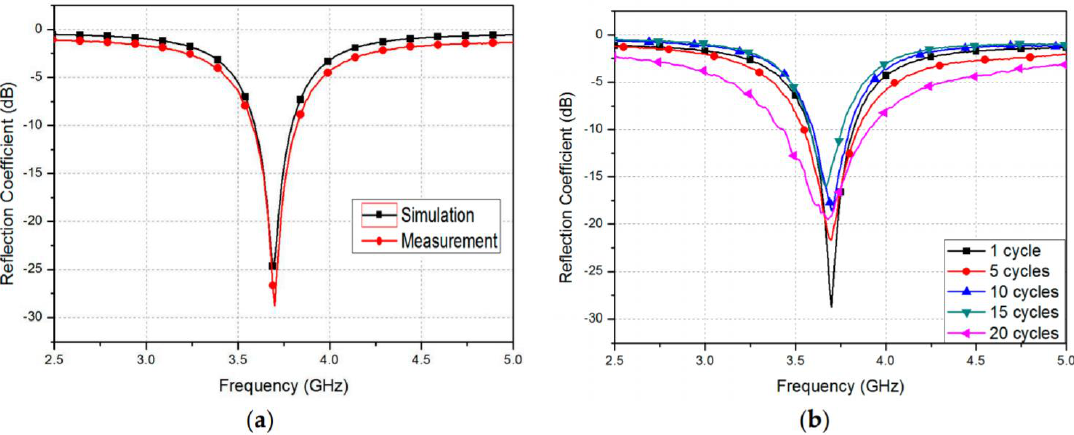
Figure 22. ( a ) Simulated and measured reflection coefficients of the proposed patch resonator before stretching; and ( b ) repeatability test of the fabricated strain sensor [78].